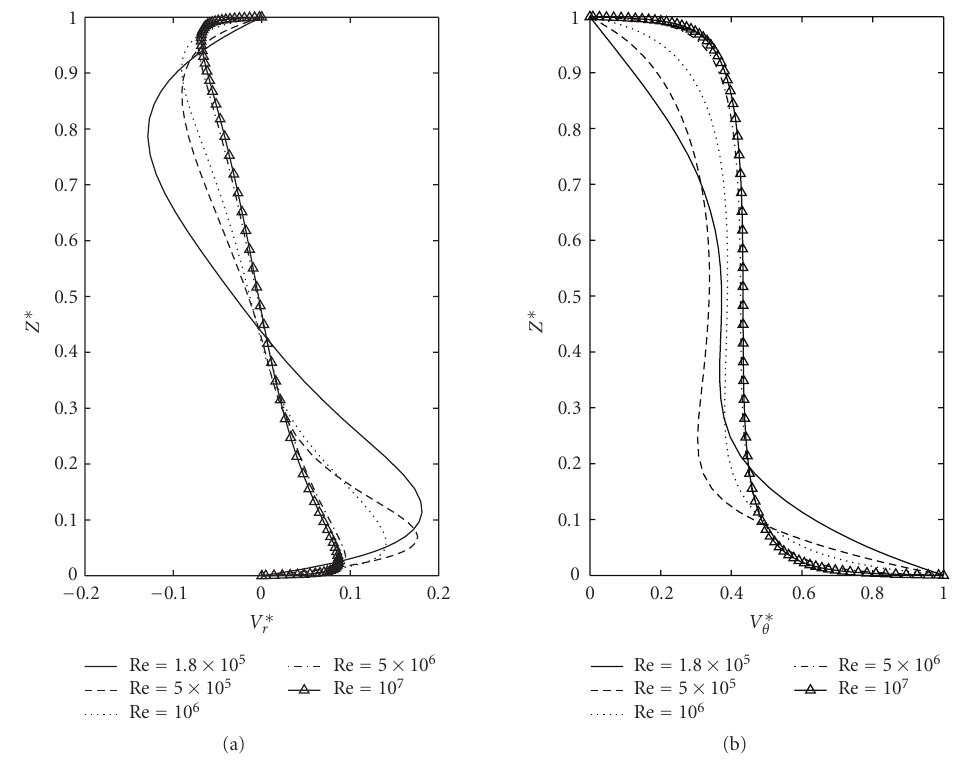
Figure 7: Axial profiles of two mean velocity components at r ∗ = 0 . 57 for G = 0 . 02 and di ff erent Reynolds